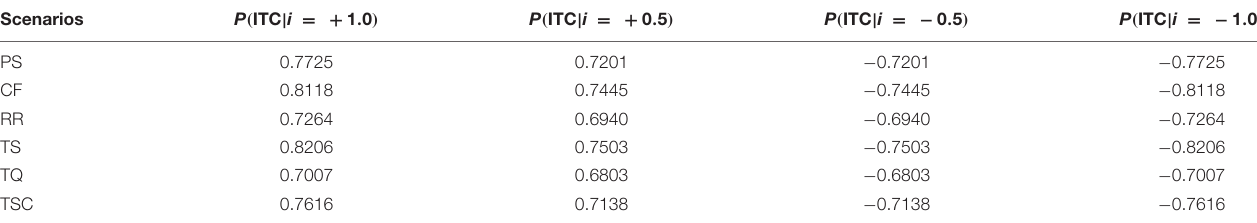
TABLE 5 | Fixed values of ITC after a set of iterations in different scenarios in the predictive analysis. Scenarios P ( ITC | i = + 1 . 0